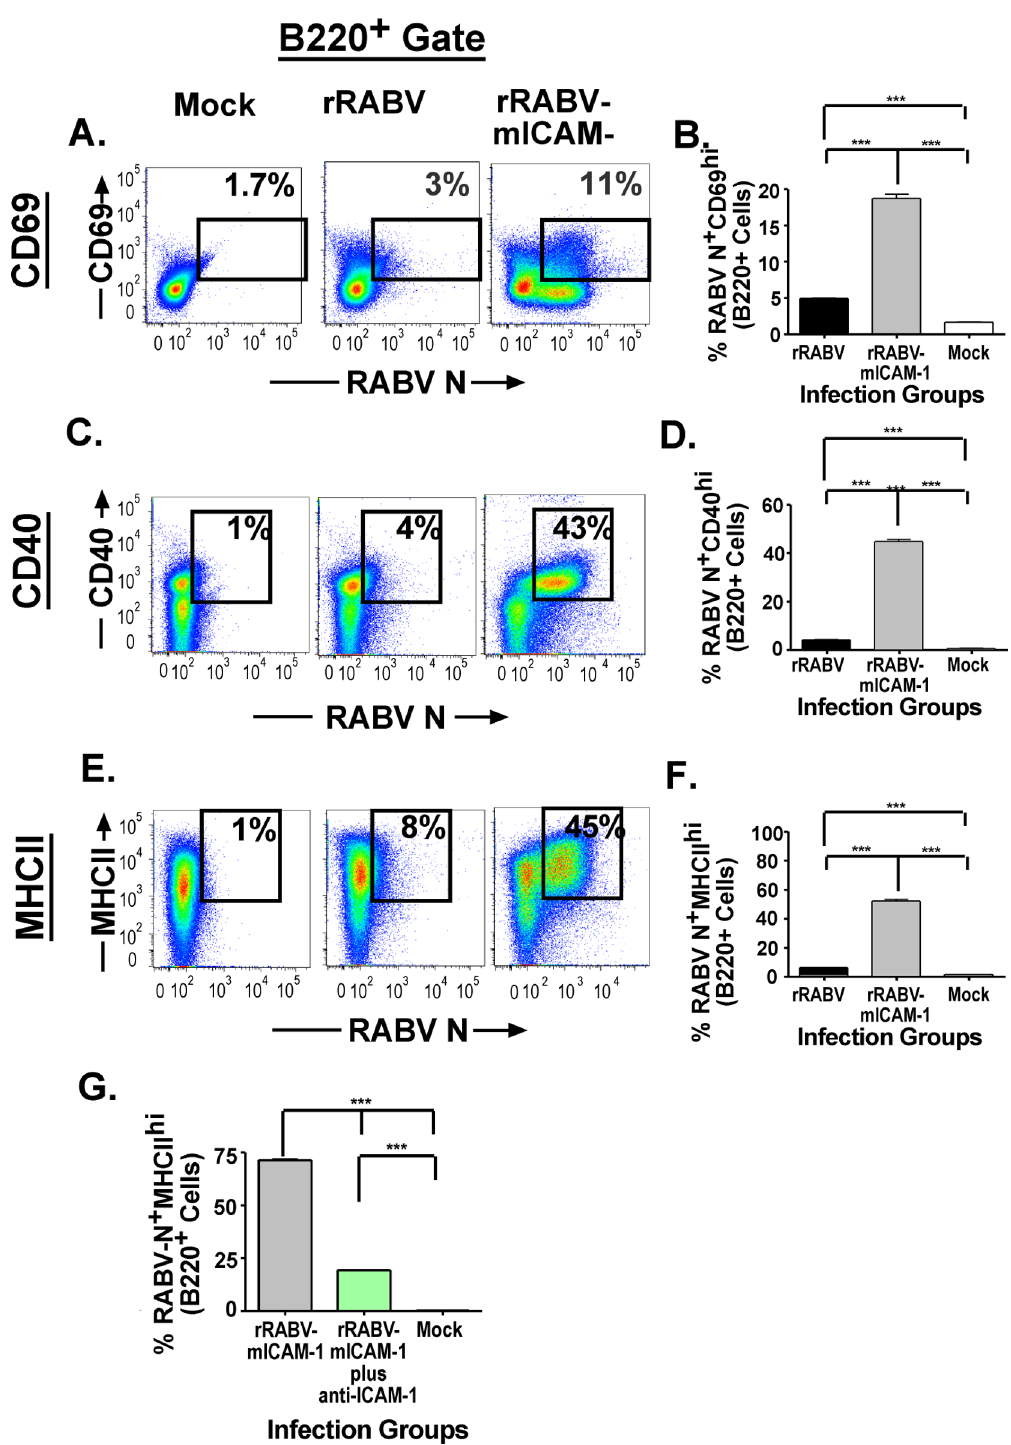
Figure 4. Infection with rRABV results in the upregulation of B cell activation markers, which are enhanced by infection with rRABV- mICAM-1. The infected splenocyte cultures described in Figure 3 were analyzed for the activation of B cells, as measured by the upregulation of cell surface expression of CD69, CD40 or MHCII in RABV N + B cells. Representative gating strategy of B220 + B cells from the total live population gated on CD69 (A), CD40 (C) or MHCII (E). The percentage of RABV N + CD69 + B cells (B), RABV N + CD40 + B cells (D) and RABV N + MHCII + B cells (F) are indicated. G) Pretreatment of sucrose-purified rRABV-mICAM-1 with a neutralizing anti-ICAM-1 antibody significantly reduced the expression of MHCII on the infected B cells in culture. To compare two groups of data, we used an unpaired, two-tailed Student’s t test. (* p , 0.05; **, p , 0.01; ***, p , 0.001)